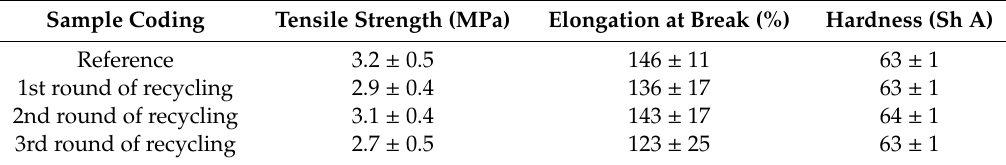
Figure 6. Appearance of GTR + EVA2 sample: ( A ) reference sample; ( B ) sample after material recycling (sample compressed in the same conditions as the reference sample). Table 8. Tensile properties of GTR + EVA2 sample as function of recycling cycles.